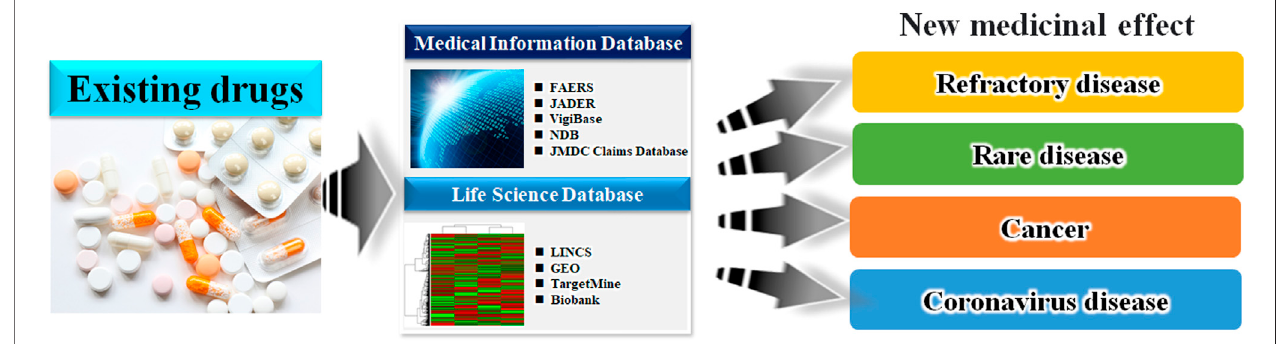
FIGURE 2 | Schematic of the database-based drug repositioning method. By analyzing the database of existing drugs, we can develop novel therapies in areas where there were no treatment options.